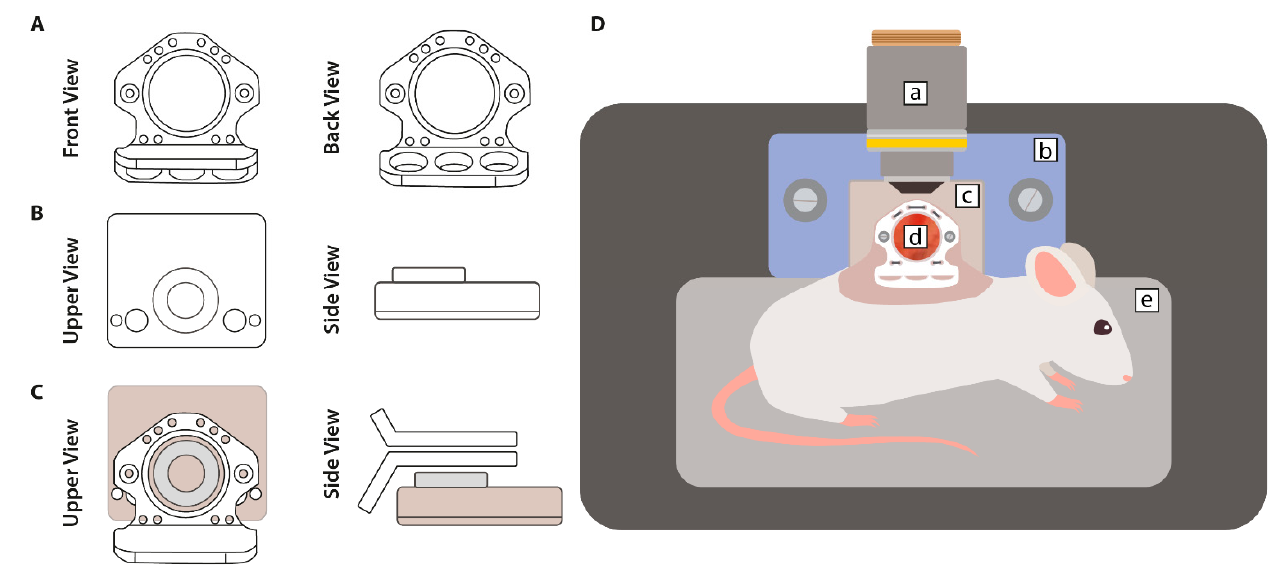
Figure 2. Illustrations of the dorsal skinfold chamber (DSC) model. ( A ) The window model consisted of two non-symmetrical frames that are made of polyether ether ketone (PEEK); ( B ) local hyperthermia was provided by an external circular resistive electric heating coil; ( C ) the window was secured to the heating element using screws in combination with the chamber-to-stage platform on the microscope; ( D ) the DSC model set-up consisted of (a) microscope objective, (b) chamber-to-stage holder, (c) external heating element, (d) dorsal skinfold chamber, and (e) heating platform for the maintenance of the core body temperature of the animal.